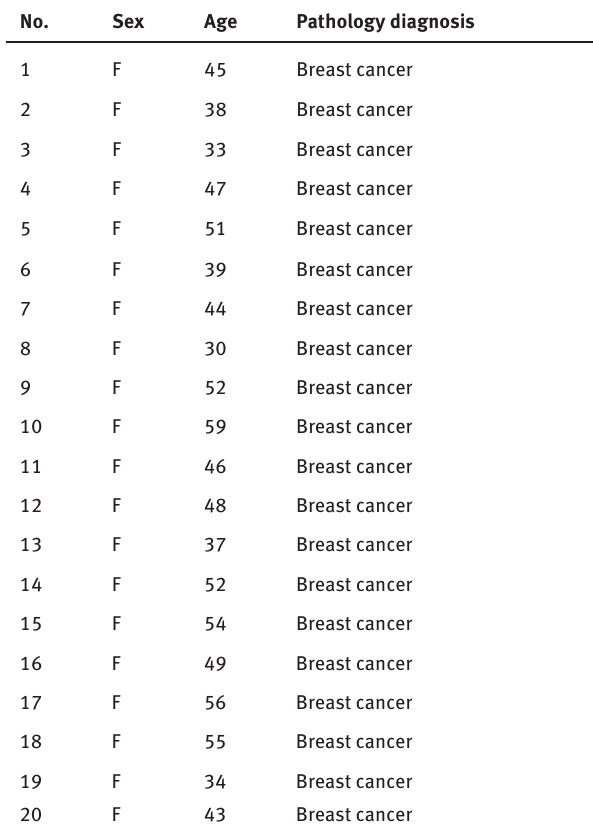
Table 1: Clinical characteristics of breast cancer